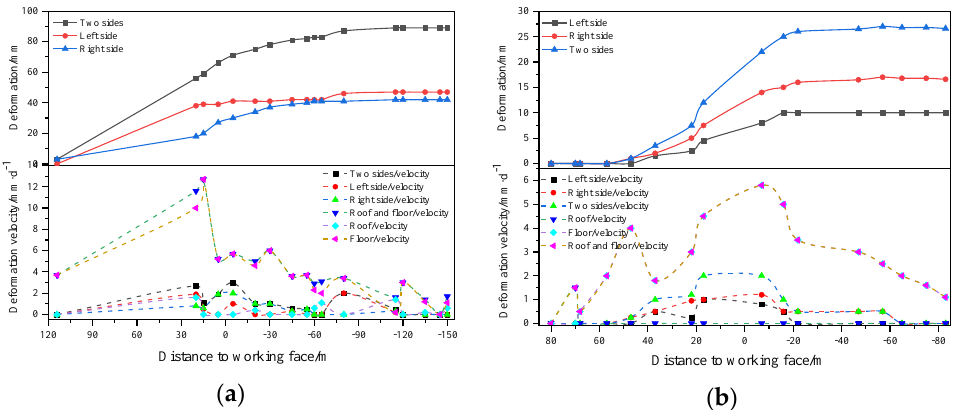
Roof and floor/velocity